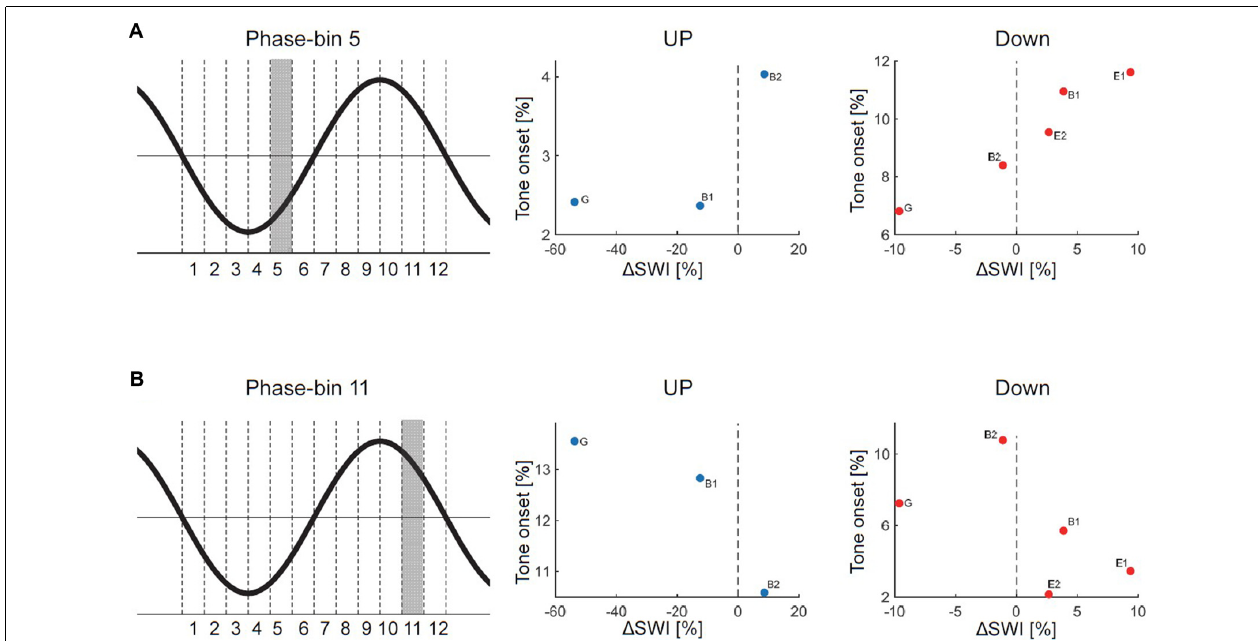
FIGURE 4 | Relationship between phase-timing of tone onset relative to the slow wave oscillation and changes in SWI after stimulation ( ∆ SWI [%] = (SWI Stim − SWI after )/SWI pre ) ∗ 100. A positive ∆ SWI value indicates that SWI was higher during stimulation, whereas a negative value indicates that SWI was lower during stimulation than after the stimulation block). The phase of the slow wave oscillation was subdivided into 12 30 ◦ phase-bins (see graphical illustration). The mean percentage of tone onsets allocated during each 30 ◦ phase-bin was calculated. (A) Data points for each patient are shown for the UP and DOWN stimulation separately for the 5th phase-bin (i.e., the onset of the EEG positive trend). The distribution of the individual data points might indicate that the more tones were played during the 5th phase-bin, the more the SWI was increased during stimulation. (B) Data points for each patient are shown for the UP and DOWN stimulation separately for the 11th phase-bin (i.e., the onset of the EEG negative trend). The distribution of the individual data points might indicate that the more tones were played during the 11th phase-bin the more the SWI was reduced during stimulation (G, generalized spike waves in sleep EEG; B, BECTS; E, ESES).